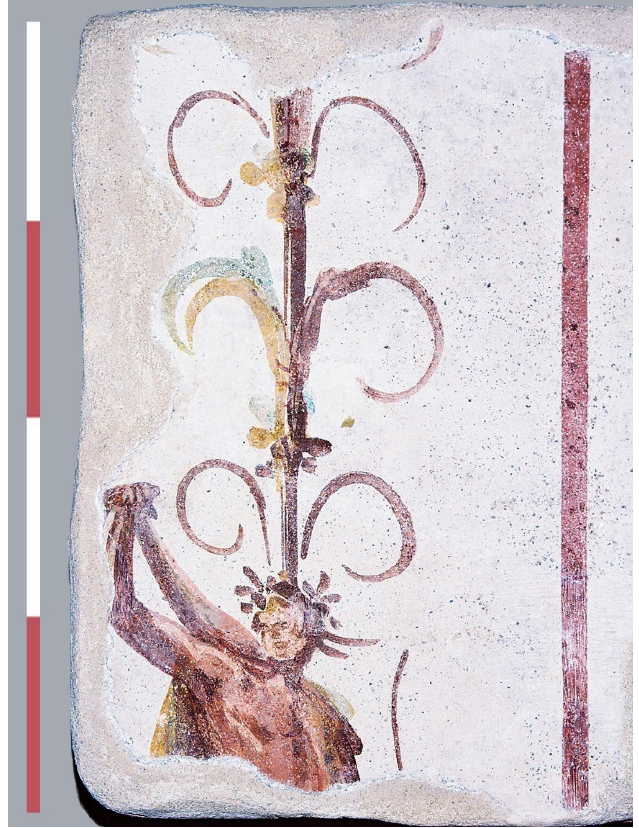
Figure 10. House H10a, representation of a male figure—probably an image of Satyr (photo Stanisław Medeksza).